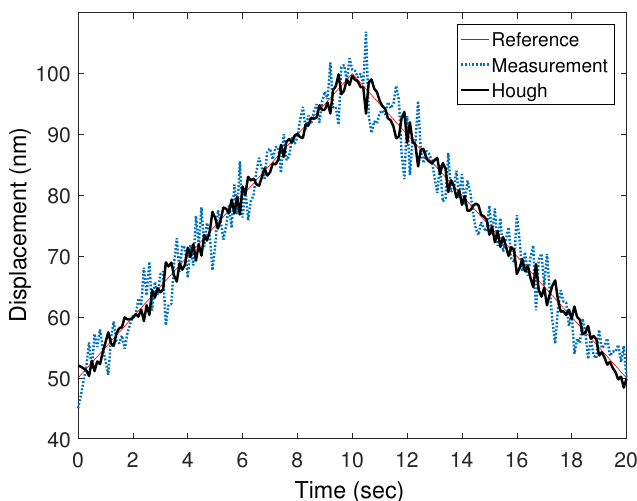
Figure 5. Nonlinearity error compensation by Hough transform